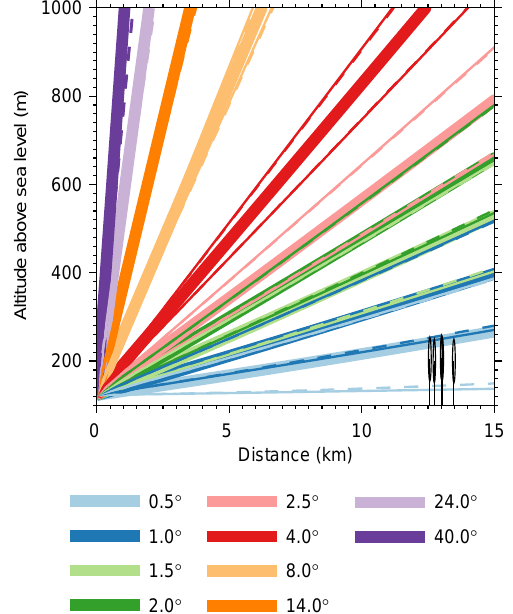
Figure 12. Beam propagation for different tilt angles calculated us- ing ray tracing. Vertical profiles of refractivity were obtained us- ing data from Sweden’s operational NWP model. Thick solid lines show the median centre of the radar beams. Thin solid lines show the 1st and the 99th percentile of the half-power beam widths for the calculated beams. Thin dashed lines show half-power beam widths using standard propagation conditions. Wind turbines are shown in